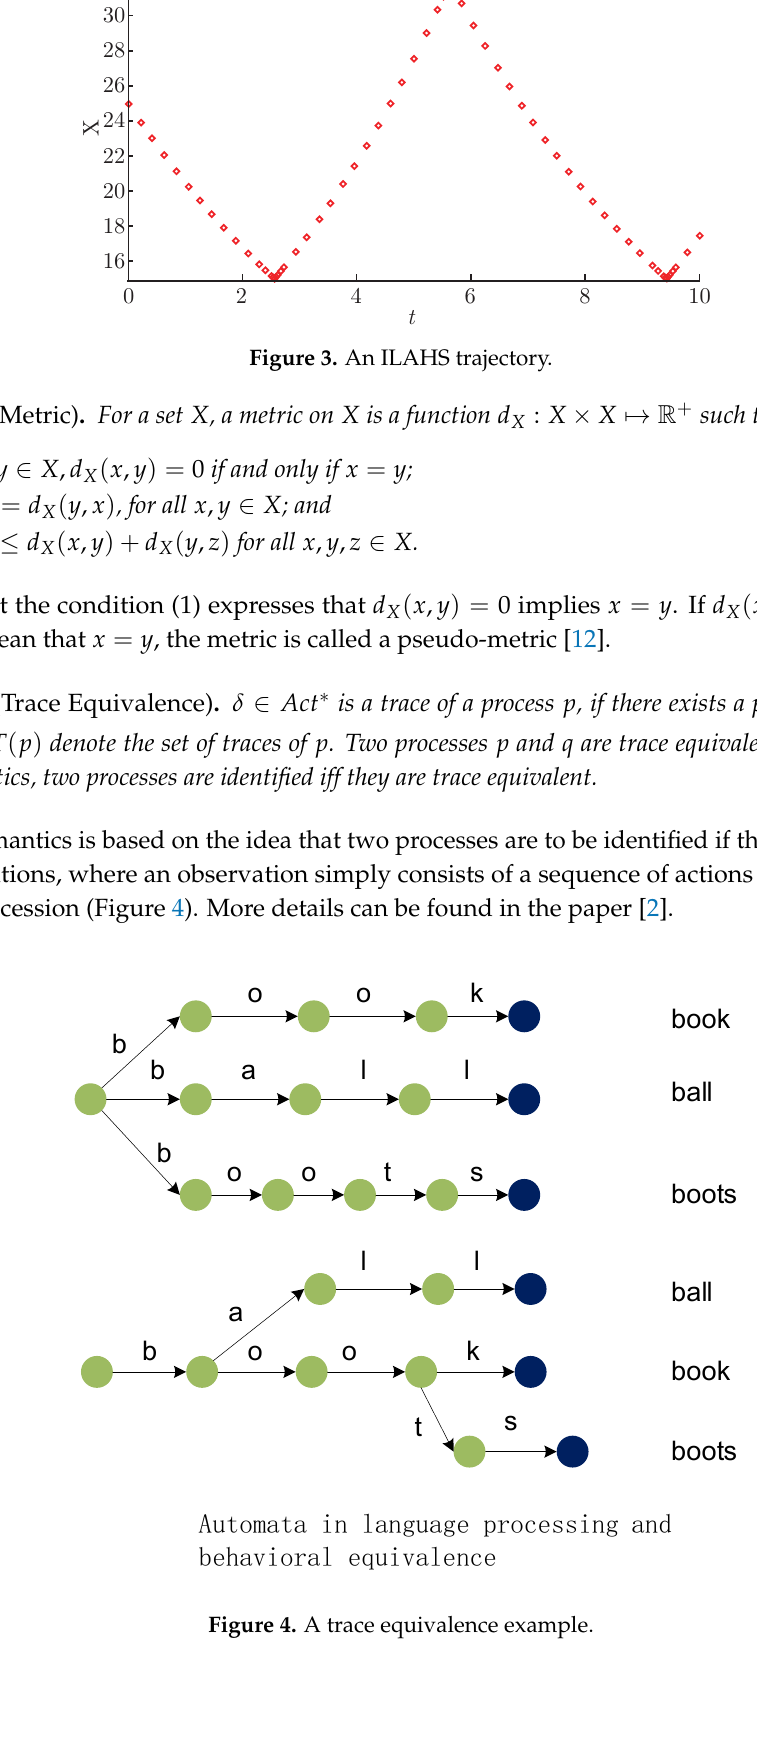
Figure 4. A trace equivalence